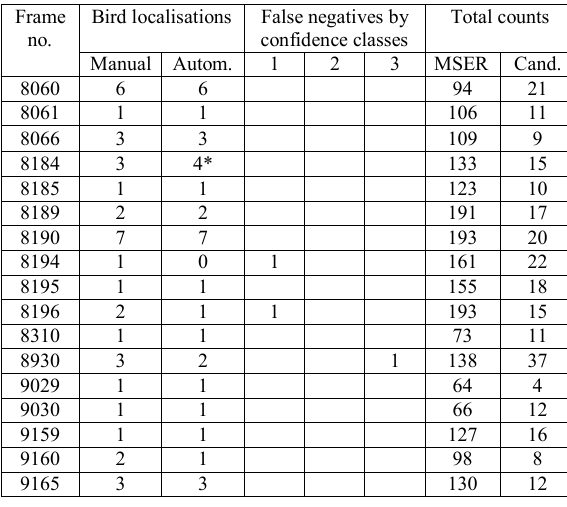
Table 1. Filter accuracy assessment for the image set taken from the southern part of the parallel survey. Highest confidence class is denoted by 1, columns 7 and 8 list the total counts of detected MSERs, and the filtered candidates and compared its results with the results of the visual examination. The results are listed in tables 1 and 2. There we further distinguish the localisations by three confidence classes determined during visual examination and classification. In the table we also list the numbers of positives in relation to the total number of candidates detected in the MSER step.